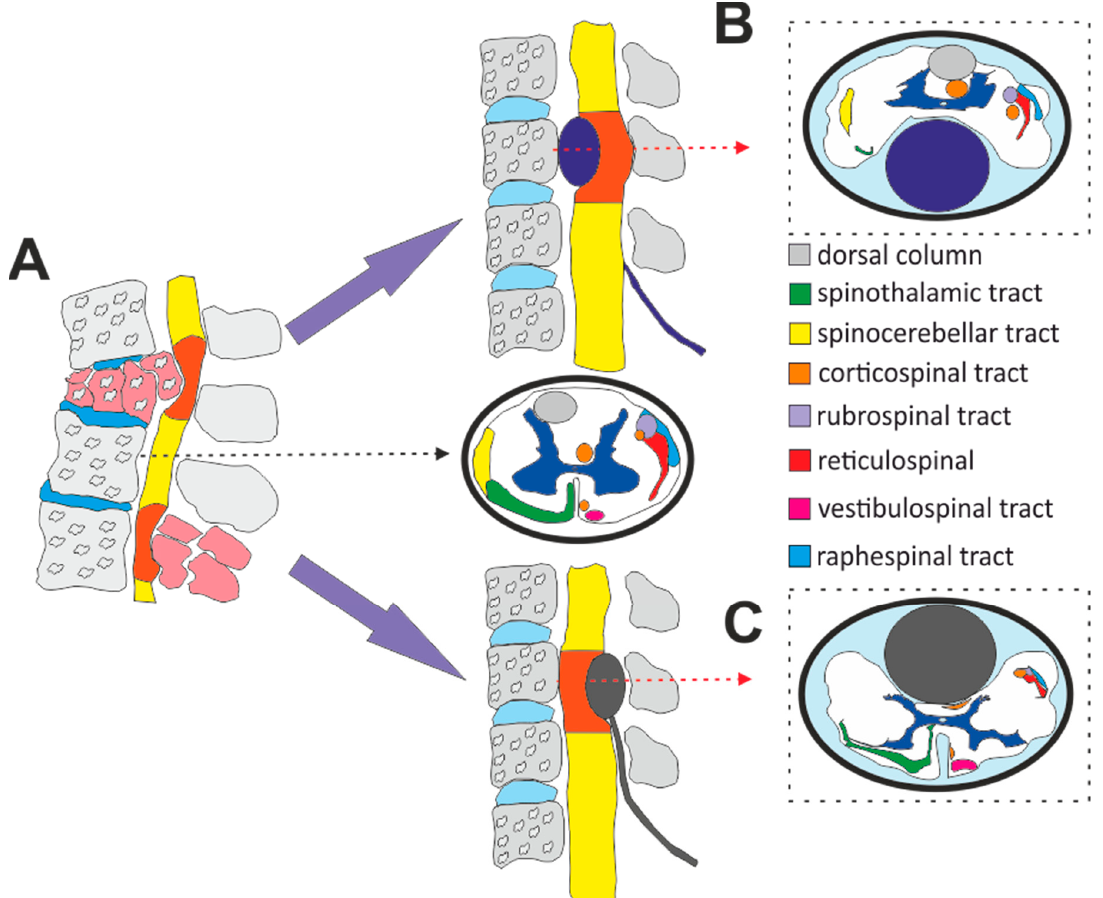
Figure 1. Illustrative image of ventral and dorsal compressive spinal cord lesions with a cross section of the uninjured spinal cord in a rat model ( A ). Inflation of the ventrally placed balloon mainly induces a lesion of the spinothalamic, vestibulospinal and ventral portion of the corticospinal tract ( B ). Classical placement of the catheter into the dorsal epidural space affects, in the first line, the dorsal portion of the corticospinal tract and the axons from dorsal columns ( C ). Black and red arrows represent the level of the cross sections.